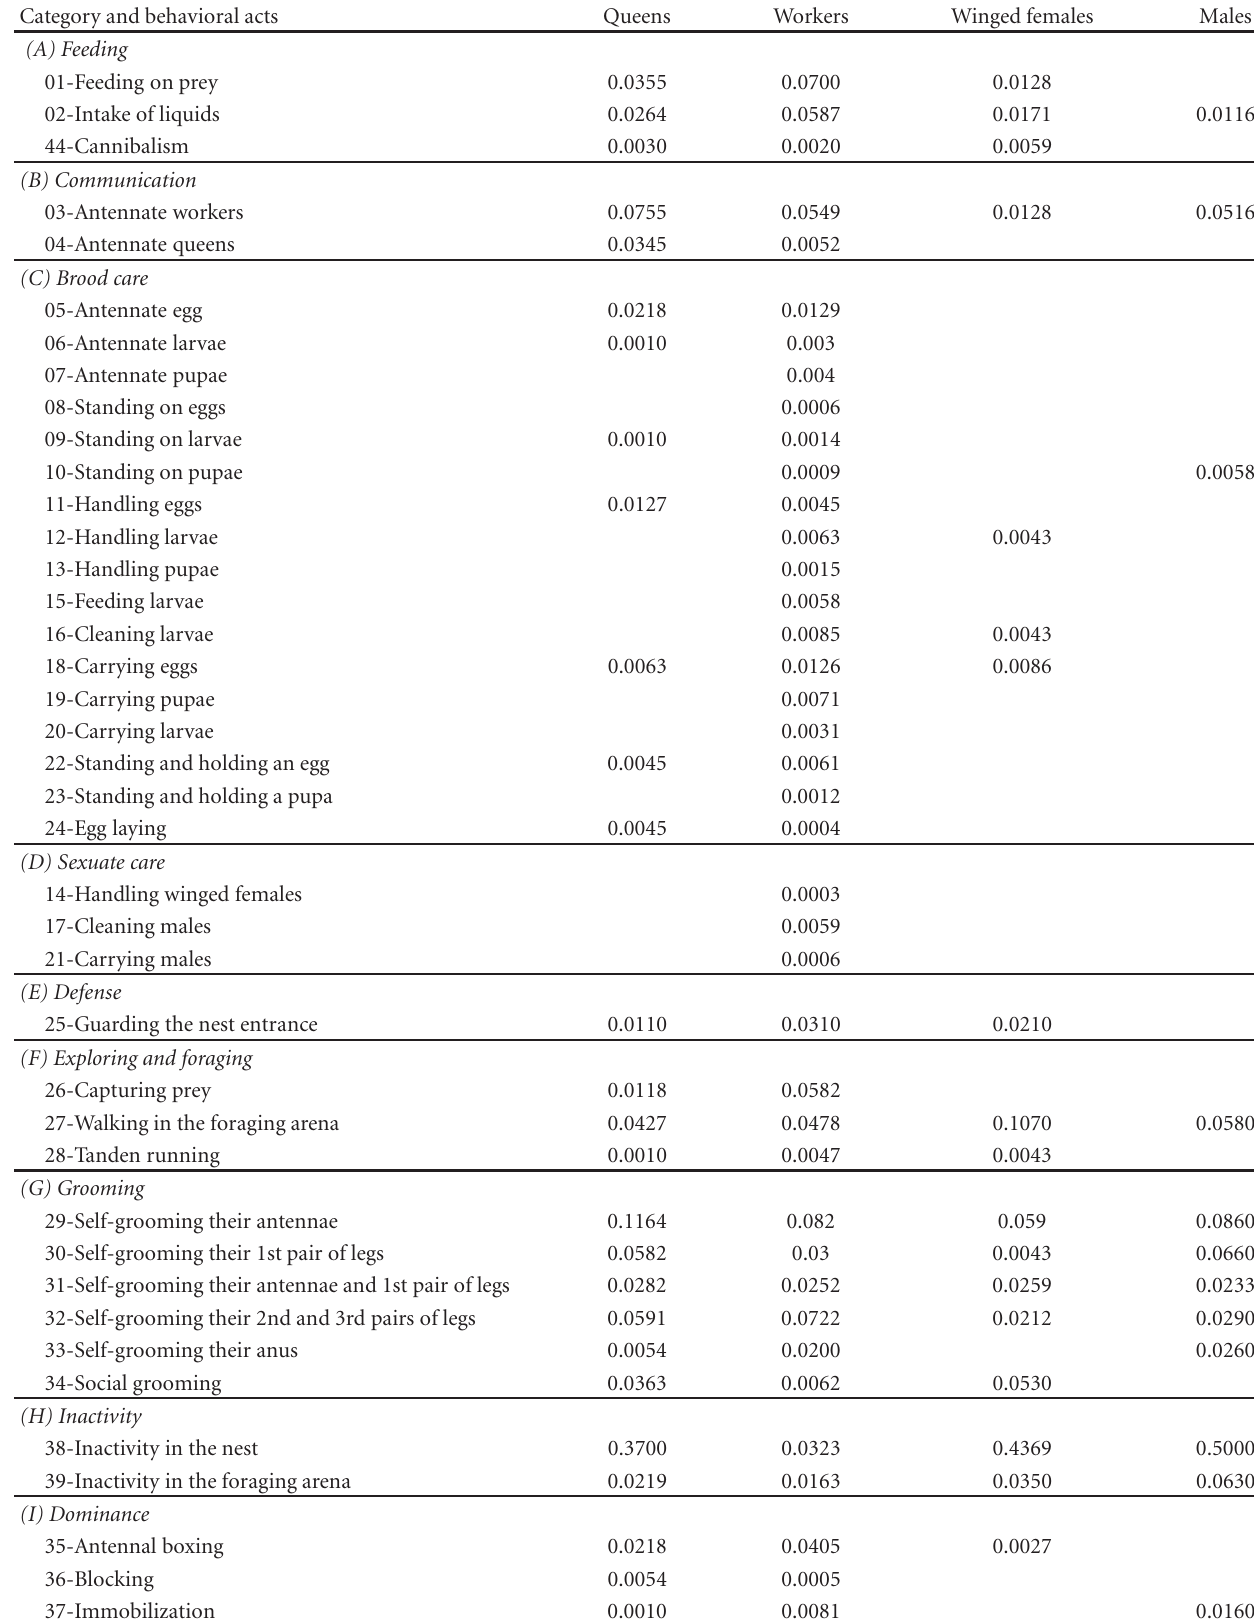
Table 2: Behavioral catalog of Pachycondyla striata